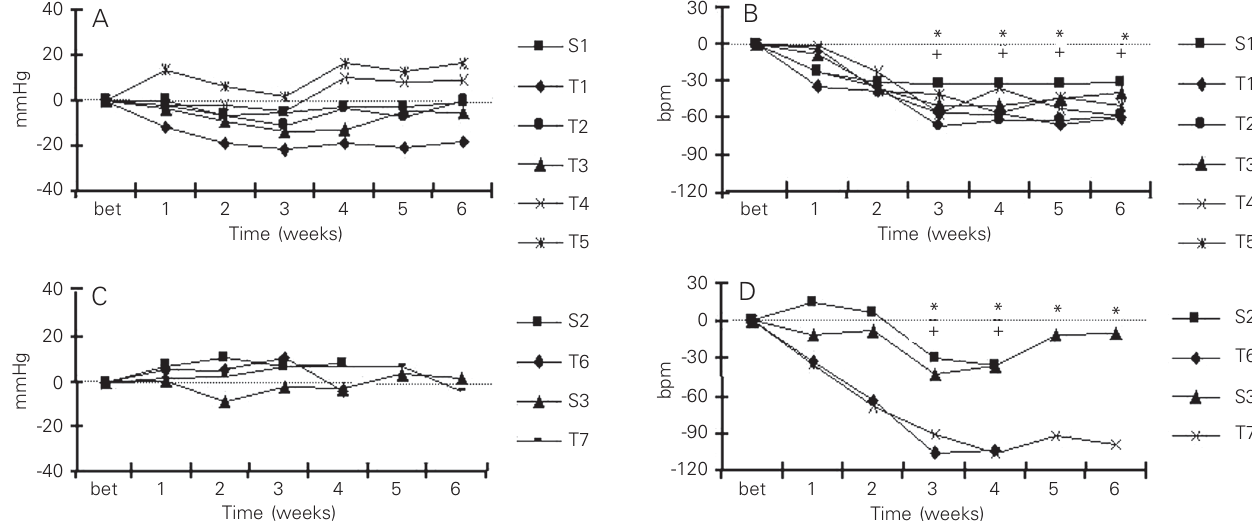
Figure 2. Resting systolic blood pressure (mmHg) and heart rate (bpm) during physical training in Protocols 1 (A and B) and 2 (C and D). Data are reported as mean ± SEM. *P < 0.05 compared to the sedentary groups S1 (B) and S2 and S3 (D) at the same time. + P < 0.05 compared to the trained groups before and after physical training (two-way ANOVA test). Resting blood pressure did not change among groups after physical training; however, heart rate decreased in all trained groups after 2-3 weeks of physical training (P < 0.05). bet = before exercise